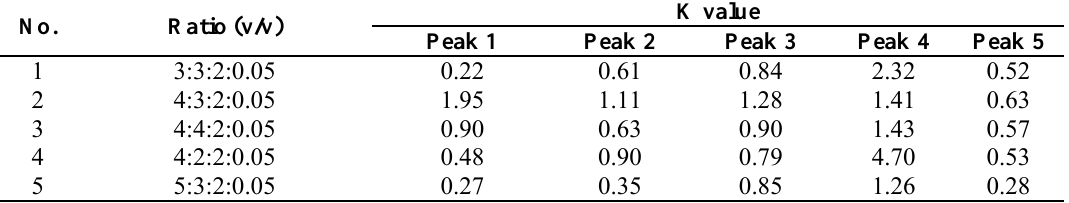
Table 1. The partition coefficients (K values) of the phenolic compounds with chloroform- methanol-water-acetic acid as the two-phase solvent system by HPLC analysis.